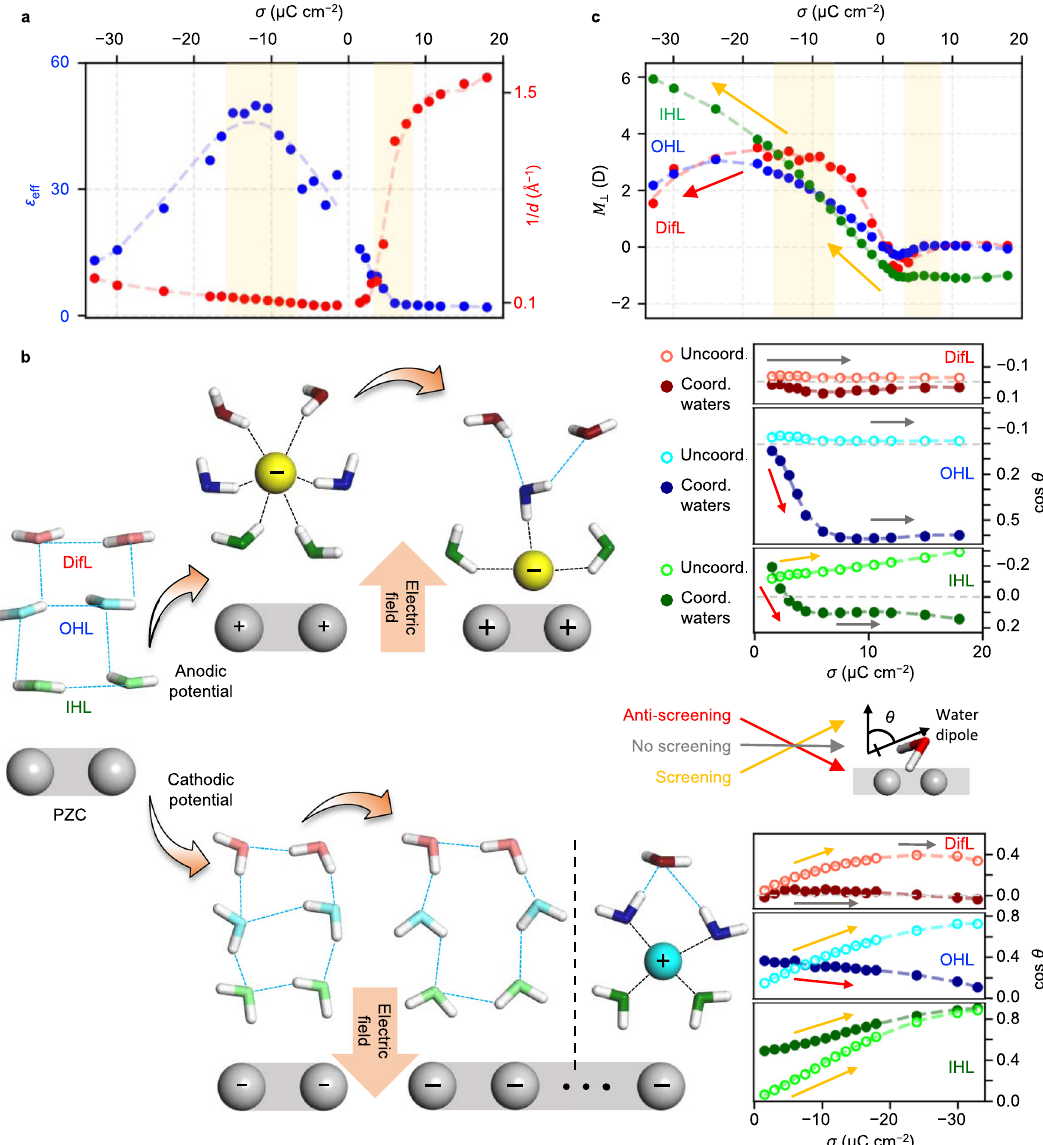
Fig. 2 EDL structural responses upon anodic and cathodic charging. a Reciprocal value of charge-separation distance, 1/ d , and effective dielectric constant, ε eff , are shown as a function of the surface charge density, σ . The regions shaded pale-yellow correspond to the σ -range responsible for the humps in the differential capacitance curve. b Schematics illustrating the structural changes of water molecules and ions upon EDL charging from the PZC (left panels). Distinct orientational responses of the water dipoles are resolved depending on the layer at which water is located and also depending on whether the ion is coordinated (coord.) or not (uncoord.) (right panels), based on the average cos θ ( θ is the angle between the water dipole and the surface normal) that is a function of σ . Depending on whether the water dipole screens or anti-screens the fi eld, the increasing or decreasing trend of cos θ is labeled using the arrows with different colors. c Surface-normal macroscopic dipole moment, M ⊥ , of different water layers is shown as a function of σ , where M ¼ ∑ i ? 2 IHL ; OHL ; DifL